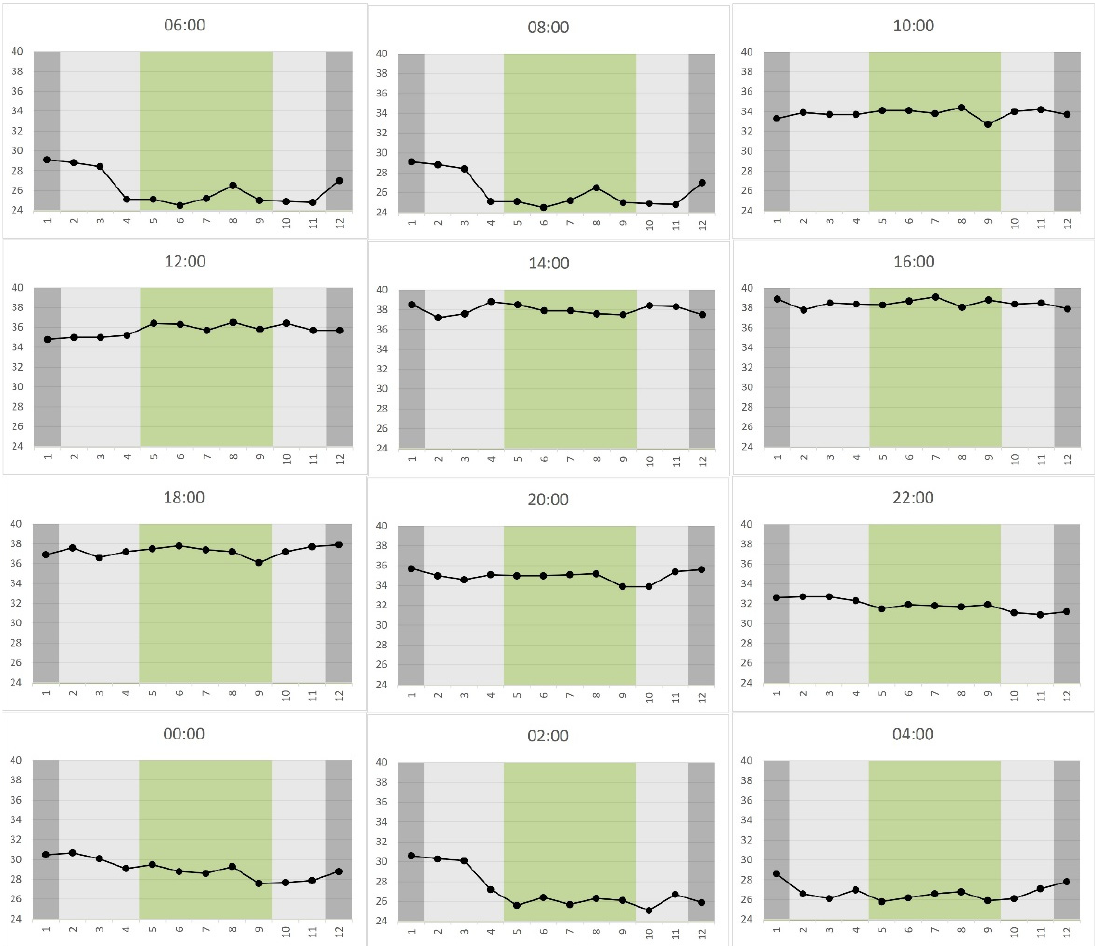
Figure 5. Transect 2—charts of single-lap measurements. LCZs are represented with different background colours: 2—dark grey; 9—light grey; B—green; Y axis reports air temperatures in ◦ C. Table 7. Significance of the difference among LCZs for each hour along the transects measurements. Average values [ ◦ C] are shown. Letters a, b represent significant differences among